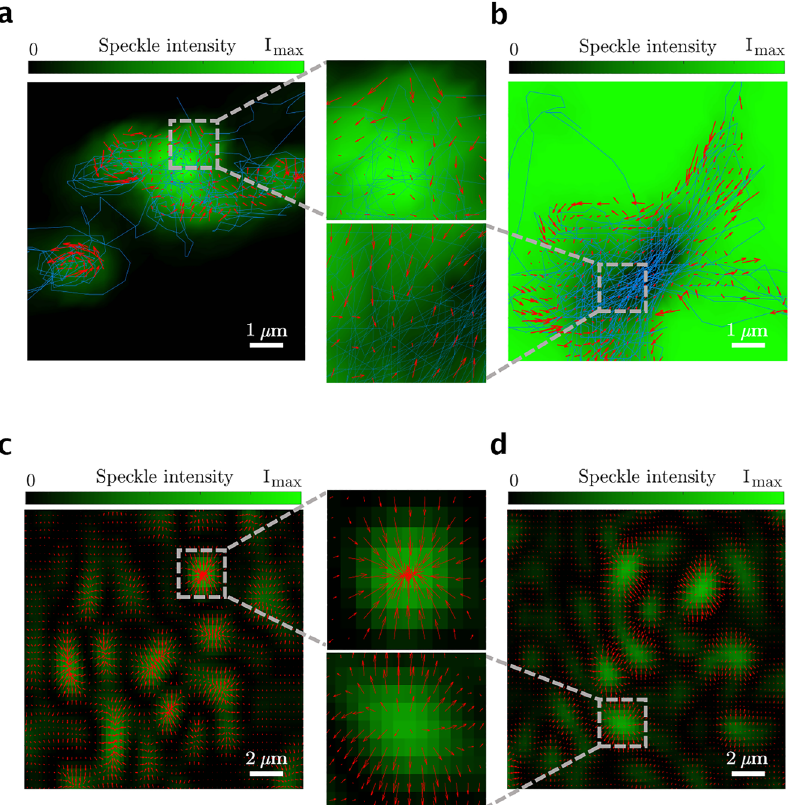
Figure 4: Microscopic optical forces in a speckle field in the transversal plane for = (a) a polystyrene (high-refractive-index, n p 1 . 59) and (b) a liposome vesicle (low- = 1 . 30), reconstructed refractive-index, n l throughtheanalysisofparticledisplacement information via the maximum-likelihood- estimator analysis method. (c) and (d) The corresponding simulated force fields in speckle fields of the same average intensity as in (a) and